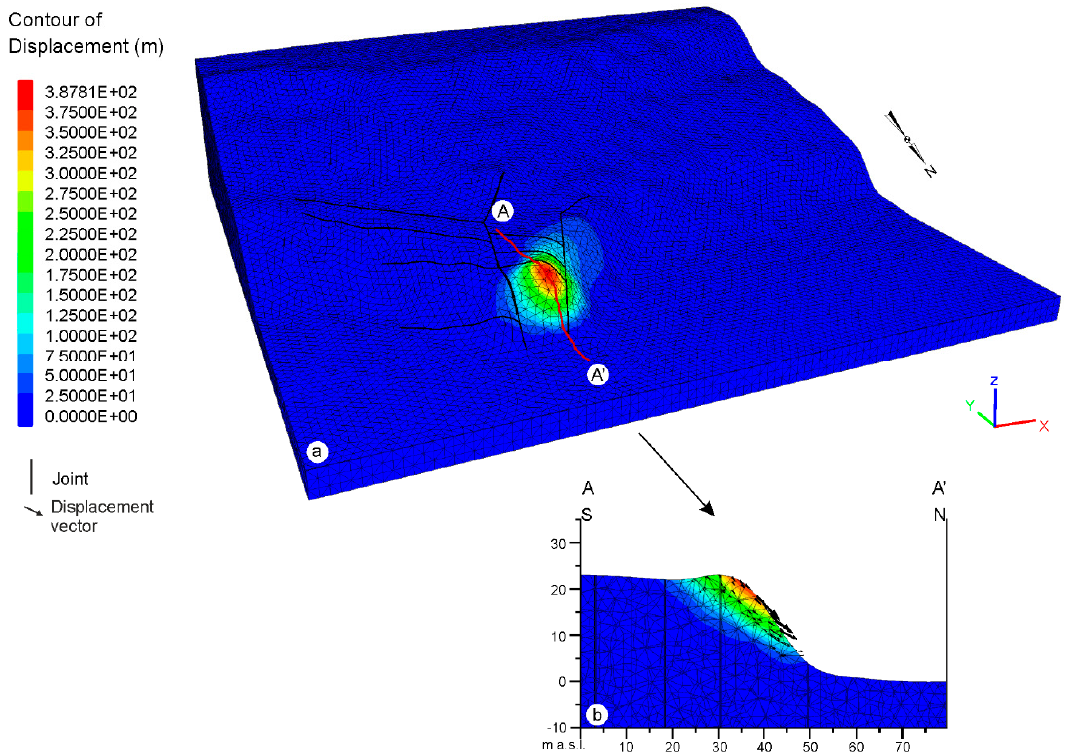
Figure 11. ( a ) The displacement contours and vectors of the Punta Lunga cliff; ( b ) the A-A’ section; and ( c ) the B-B’